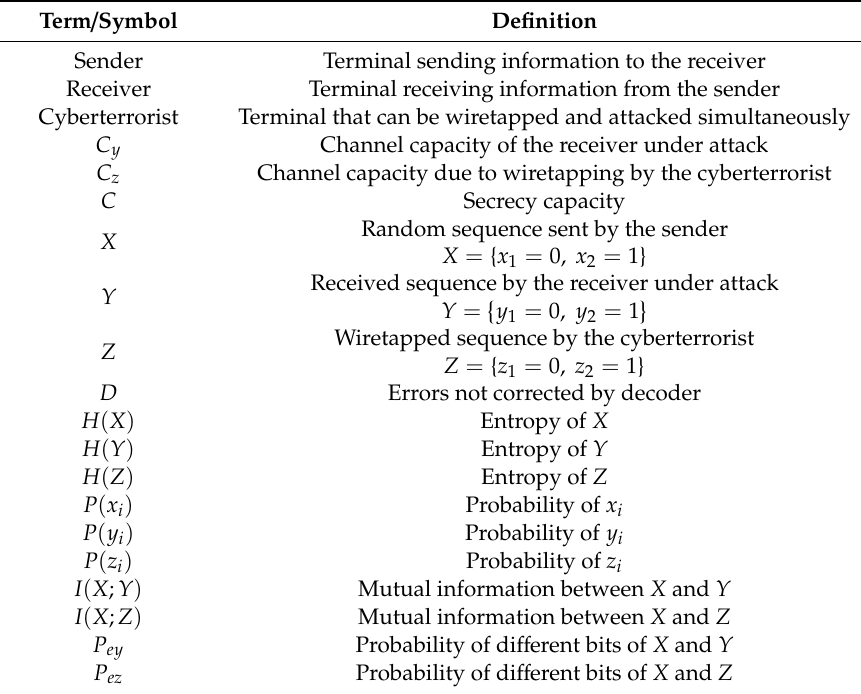
Table 2. Definitions of terms and